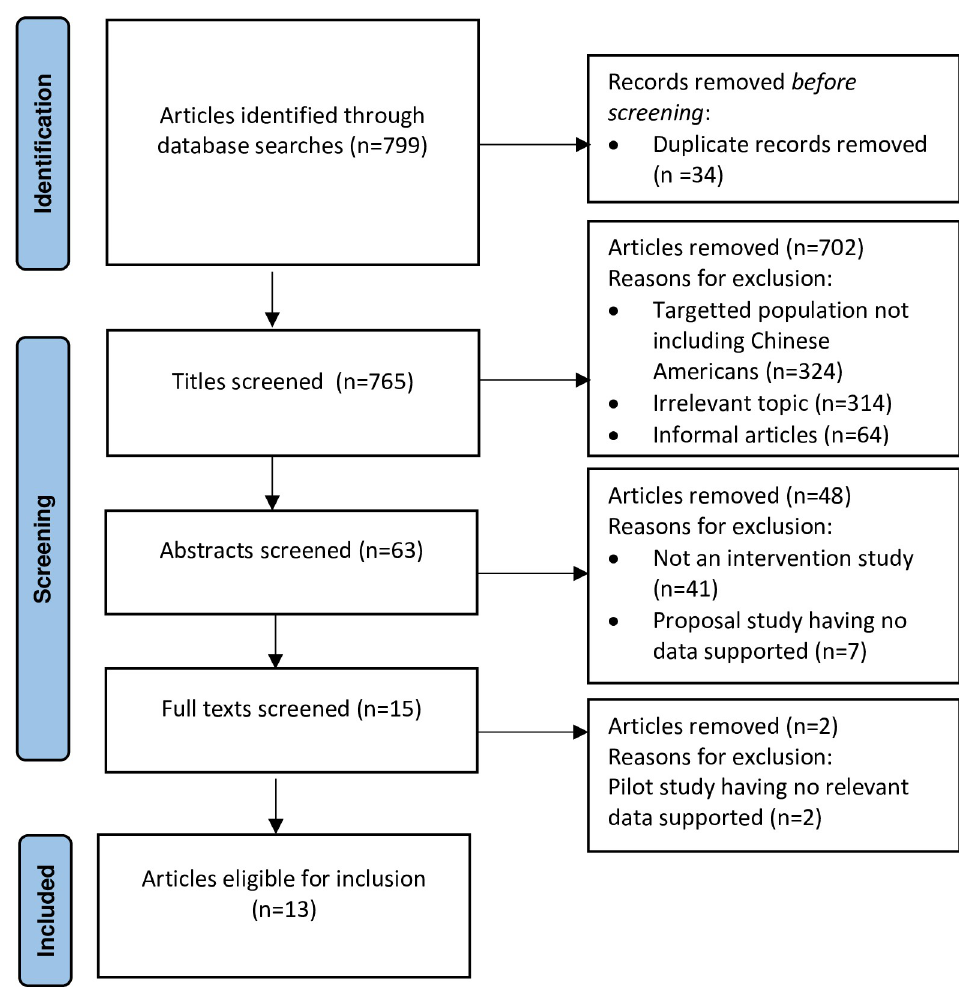
Fig 1. PRISMA flow chart documenting the study selection